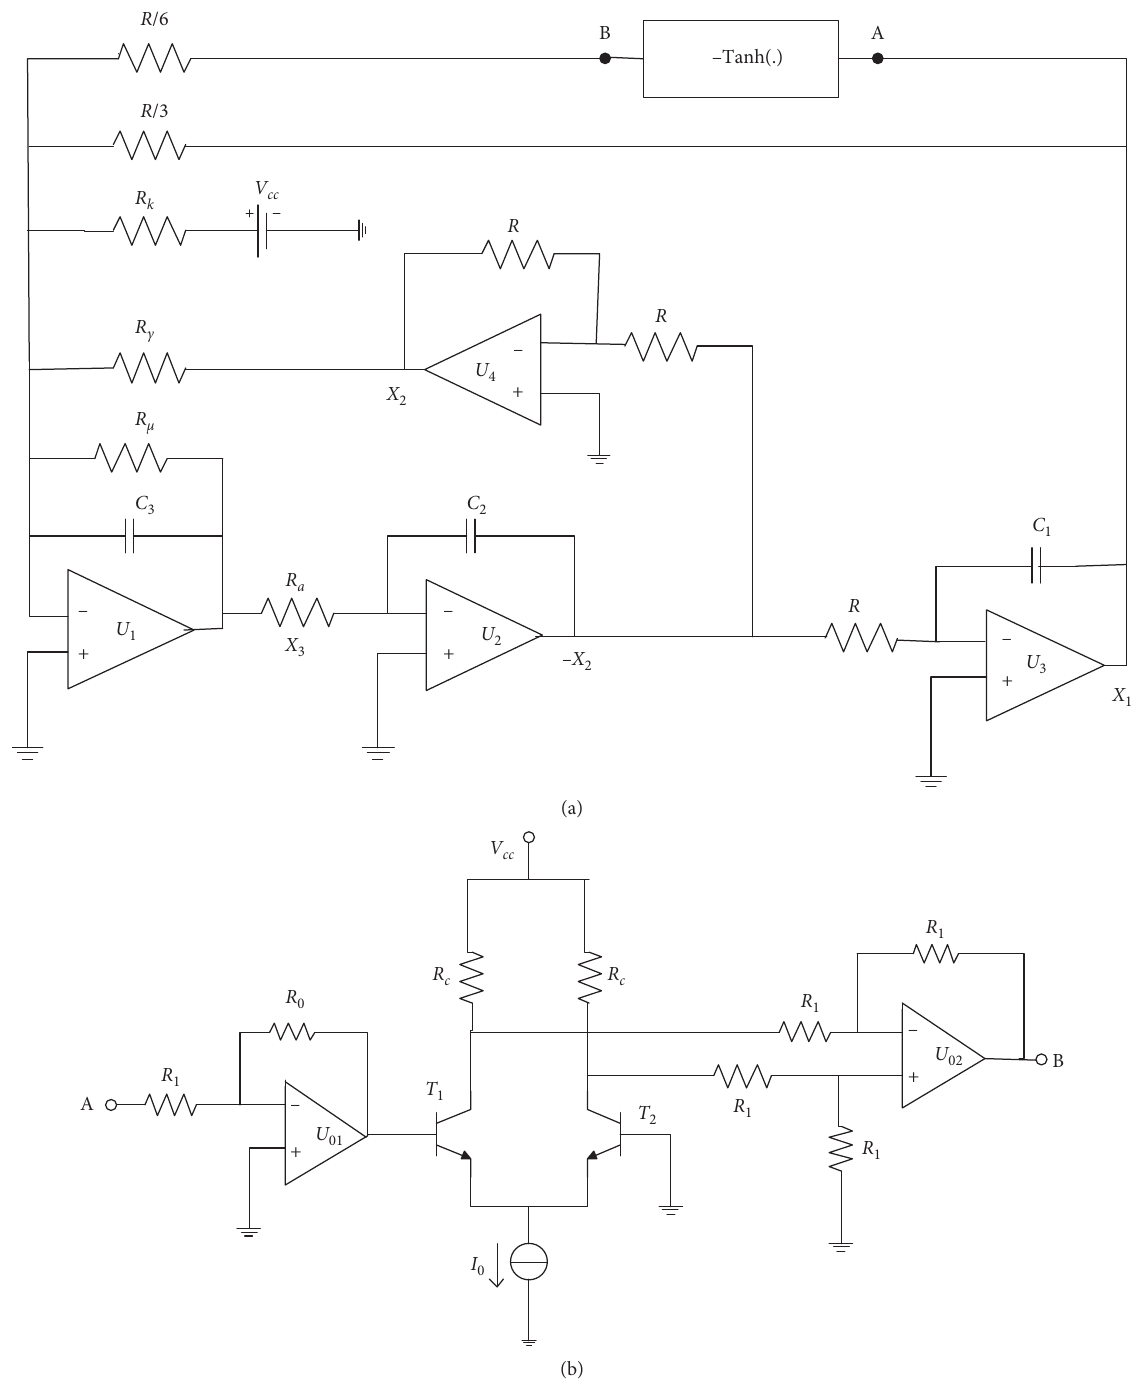
Figure 16: Electronic circuit implementation (a) of system. The circuit realization of tangent hyperbolic values function is shown in (b). The values of electronic circuit components used for the analysis are listed in Table